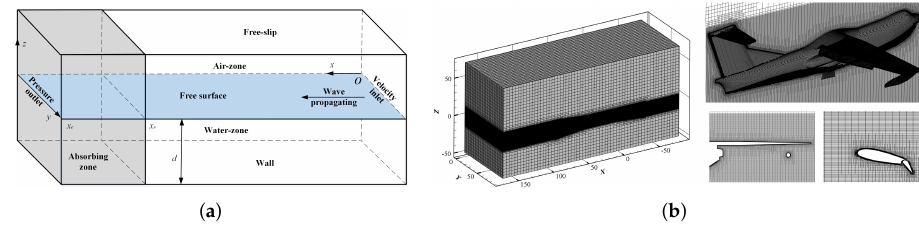
Figure 1. Computational case setup: ( a ) boundary condition; ( b ) simulation